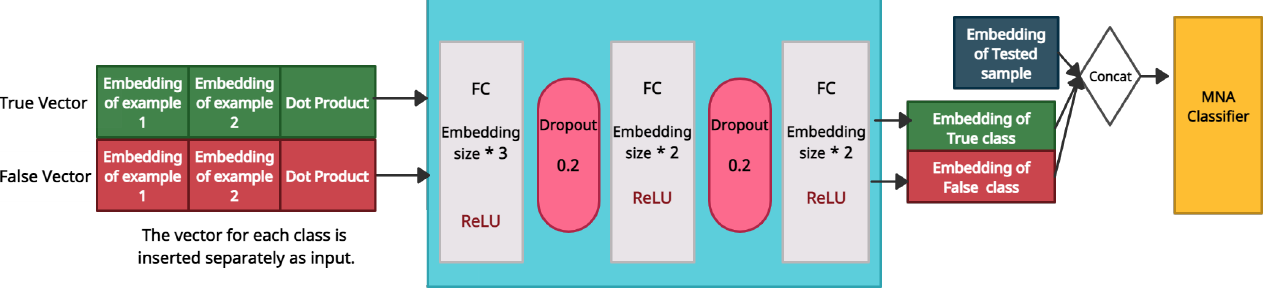
Figure 2. An Illustration of CHAML Model.